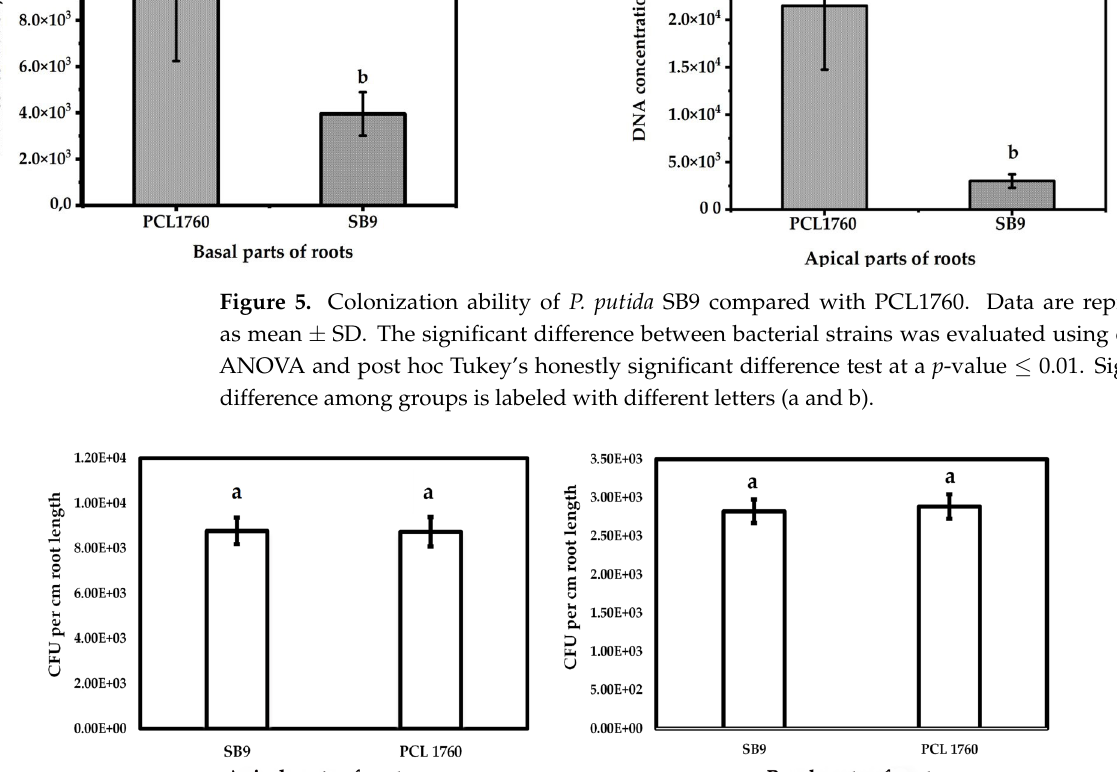
Figure 7. Generation of persister cells of PCL170 strains. PCL1760, PCL1760R, SB9, SB9R, SB9’, SB9’R as a wild type PCL1760, a wild type PCL1760 pretreated with L-rhamnose, the rsf S gene deleted mutant of PCL1760, SB9 pretreated with L-rhamnose, the complementary recombinant of SB9, and complementary recombinant of SB9 pretreated with L-rhamnose, respectively. Data are represented as mean ± SD. PCL1760 PCL1760R